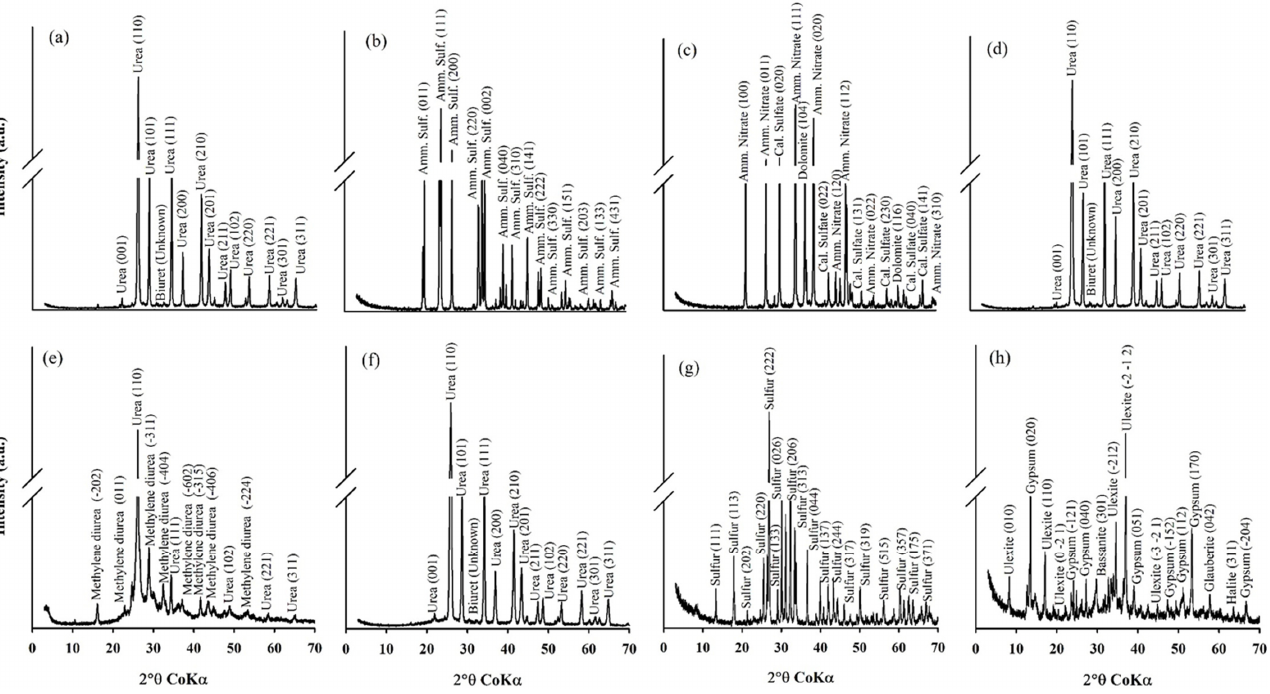
Figure 3. X-ray diffraction of the urea (Ur) ( a ), ammonium sulfate ( b ), ammonium nitrate + calcium sulfate ( c ), Ur-NBPT + Duromide ( d ), Ur-formaldehyde ( e ), PCU + Ur-NBPT + NI ( f ), elemental sulfur ( g ) and ulexite ( h ) for conventional and enhanced efficiency nitrogen fertilizers characterization.